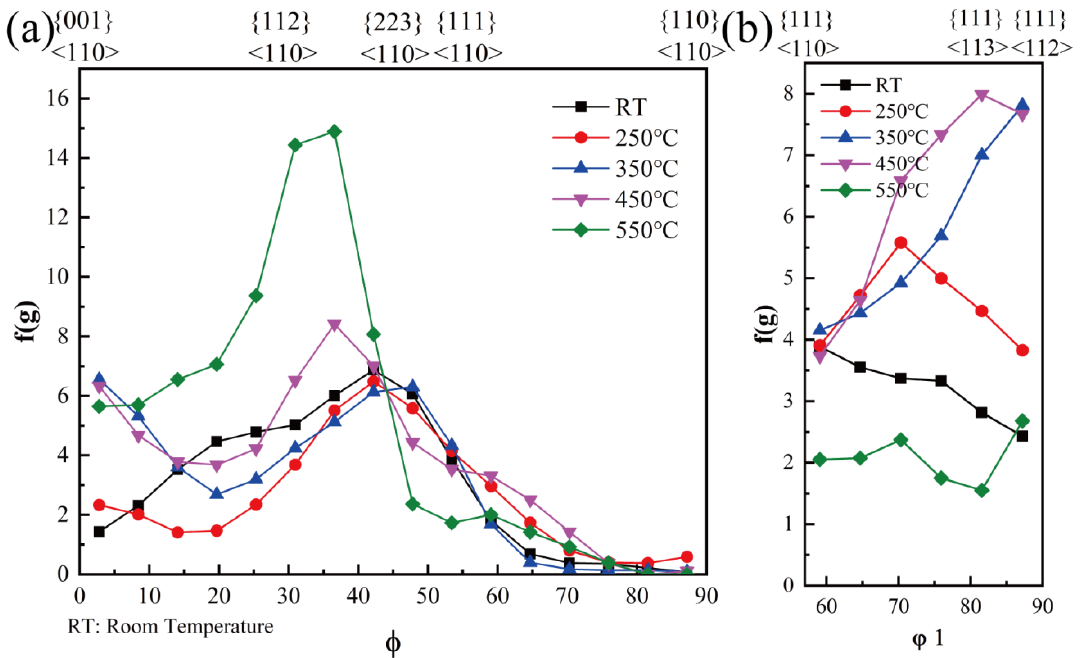
Figure 5. Orientation density at different rolling temperatures. ( a ) α-Orientation: strong intensity between {112}<110> and {223}<110>; and ( b ) γ-orientation: high density at 450 °C.